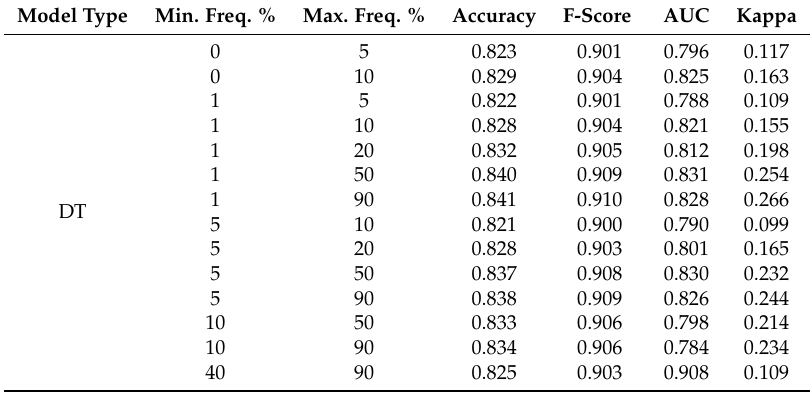
Figure 6. Summary of the results for the generator failures using a decision tree model. The vertical axis indicates the minimal frequency in % of a word in the training dataset in order to be selected by the model. The horizontal axis indicates the maximum frequency in %. Each of the panels shows a different metric for the same experiment. ( a ) shows the accuracy %, ( b ) the F-score in %, ( c ) the kappa in % and ( d ) indicates the area under the curve (AUC). Empty blocks (ranges) are values that cannot be calculated are from a prediction with a unique class output. Table 2. Classification metrics results for gearbox failures with Decision Trees and Random Forest models. Min. frequency % and max. frequency % columns indicate the minimal and maximal frequency that a word has to be in the training dataset to be chosen to train the